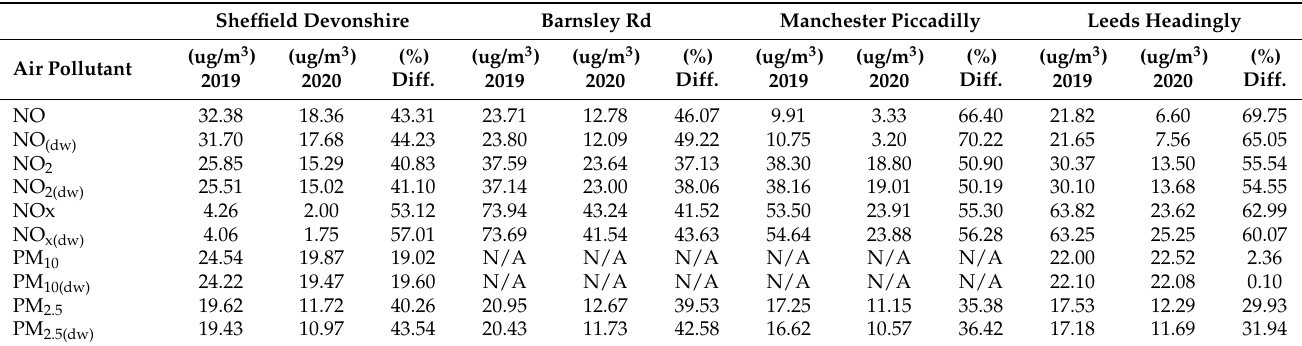
Table 4. Change (%) in air pollutant concentrations during the lockdown in 2020 as compared with the same period in 2019 at all AQMS, where dw = deweathered, diff =